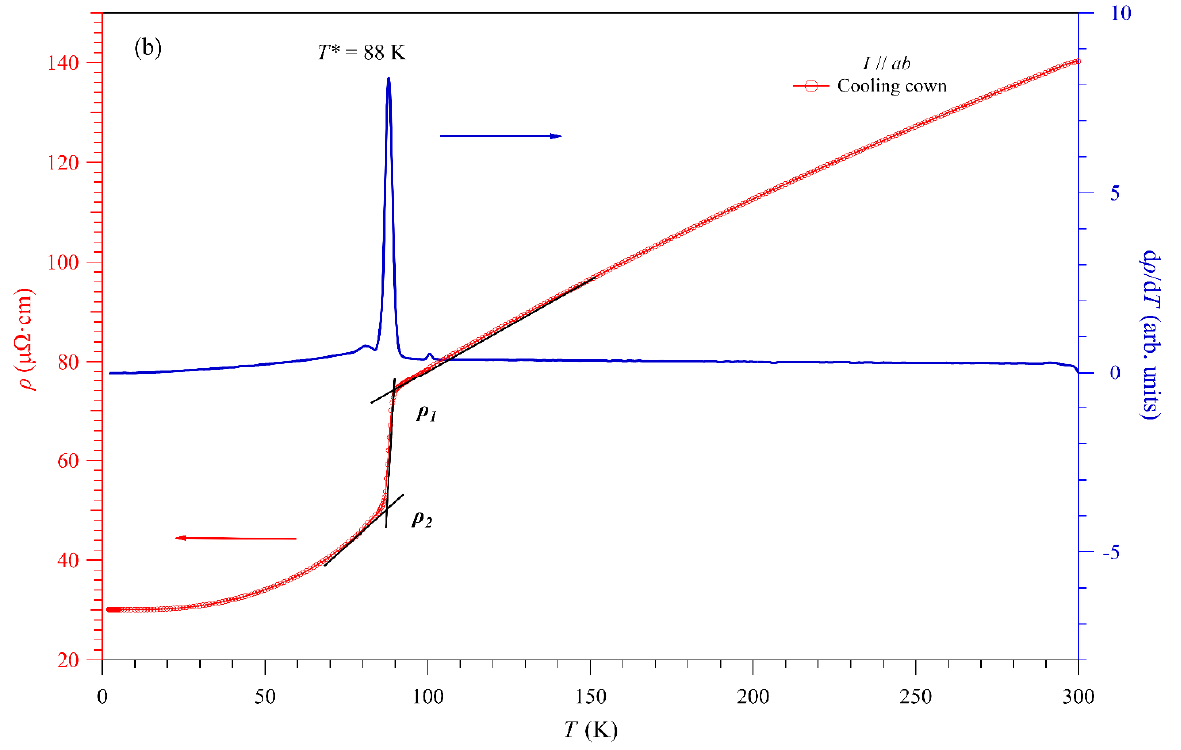
Figure 1. ( a ) Observed (red circle), calculated (black line), and difference (blue line) XRD profiles of ScV 6 Sn 6 after Rietveld refinements. Inset of ( a ) shows the crystal structure of ScV 6 Sn 6 . ( b ) Temperature dependence of in-plane resistivity ρ ( T ) and its derivative d ρ /d T of ScV 6 Sn 6 single crystal from 2 to 300 K at ambient pressure.